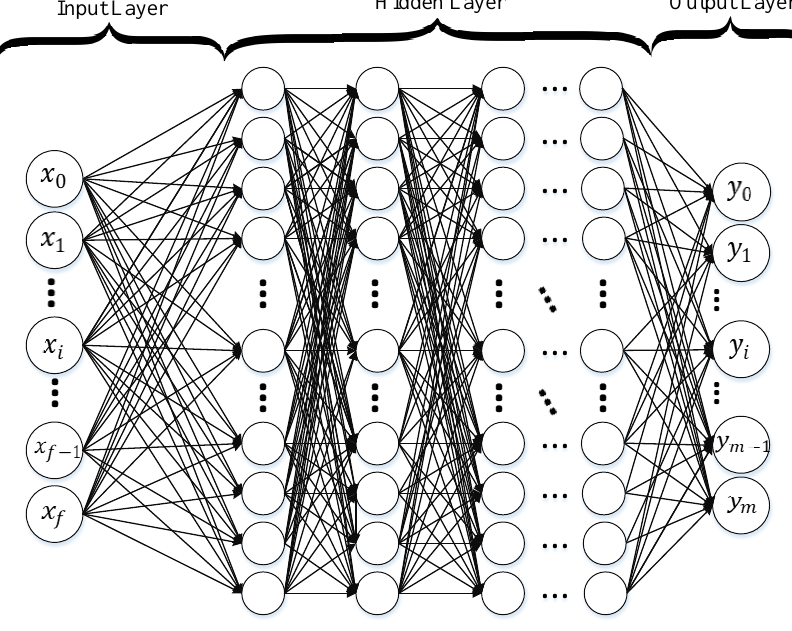
Figure 16. Standard, fully connected deep neural network